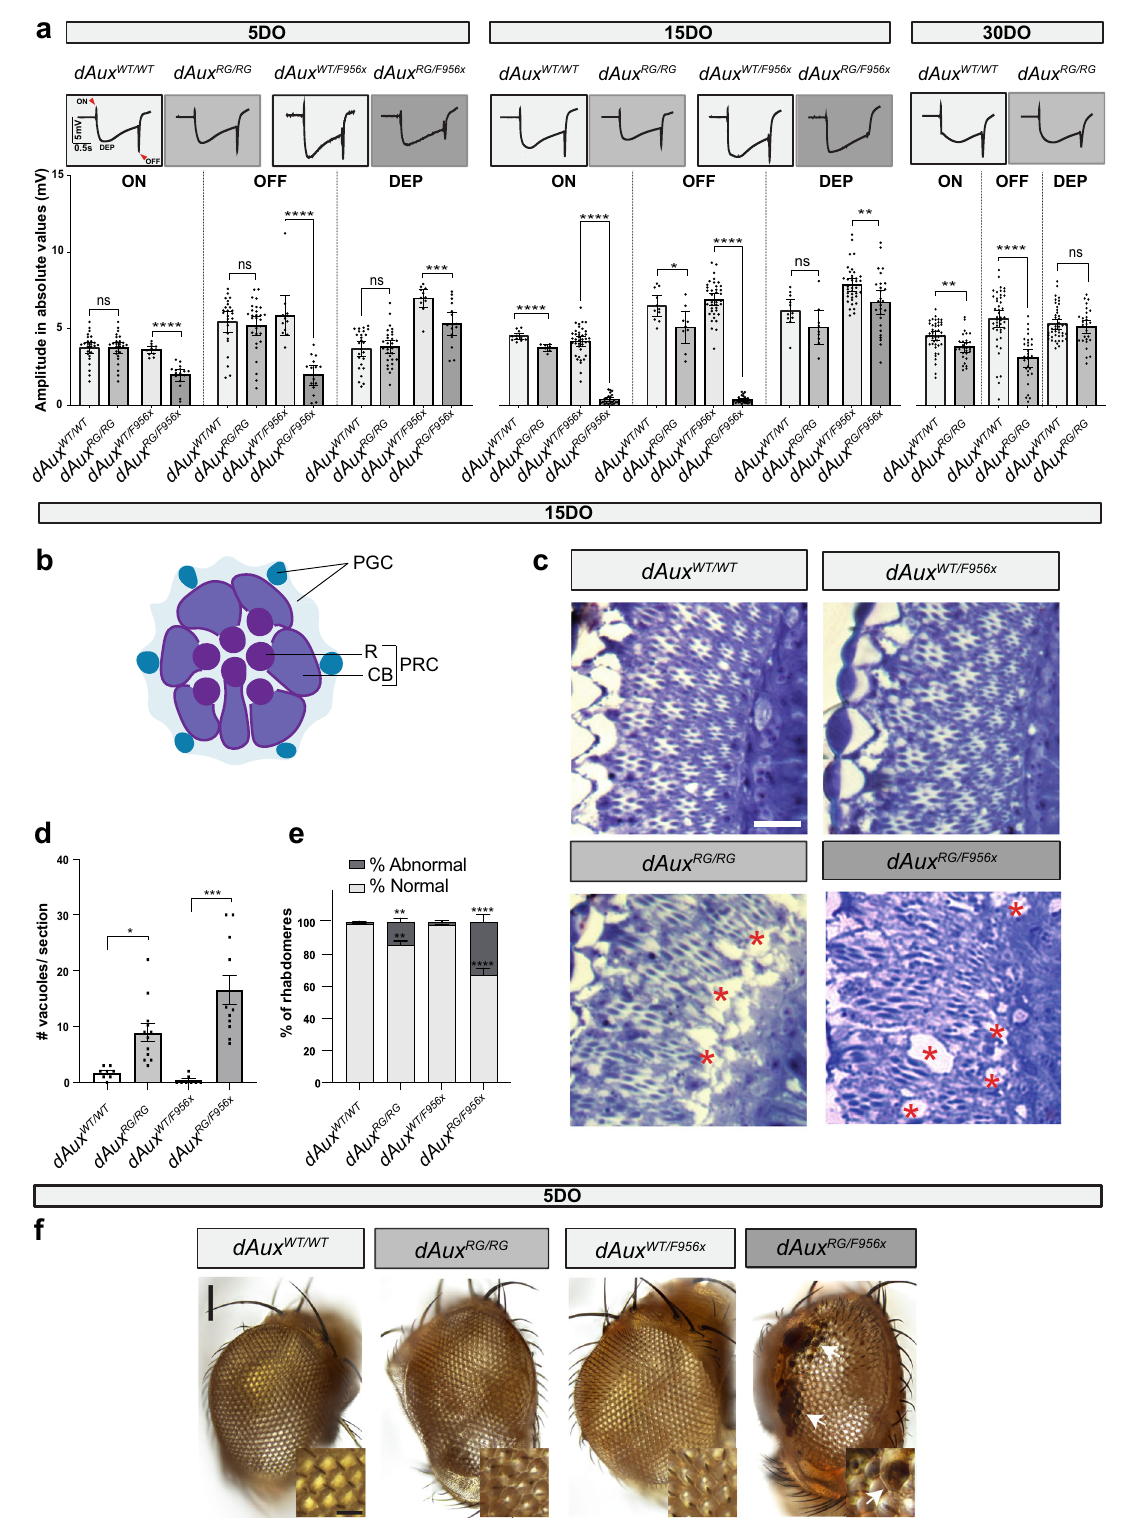
Synj1 35,36,61,64,65 . Given this evidence and that patients with mutations in SYNJ1 show clinical phenotypes very similar to patients with mutations in DNAJC6 7,8,29 – 31 , we examined if the pathogenic dAux RG mutation functionally interacts with Synj .